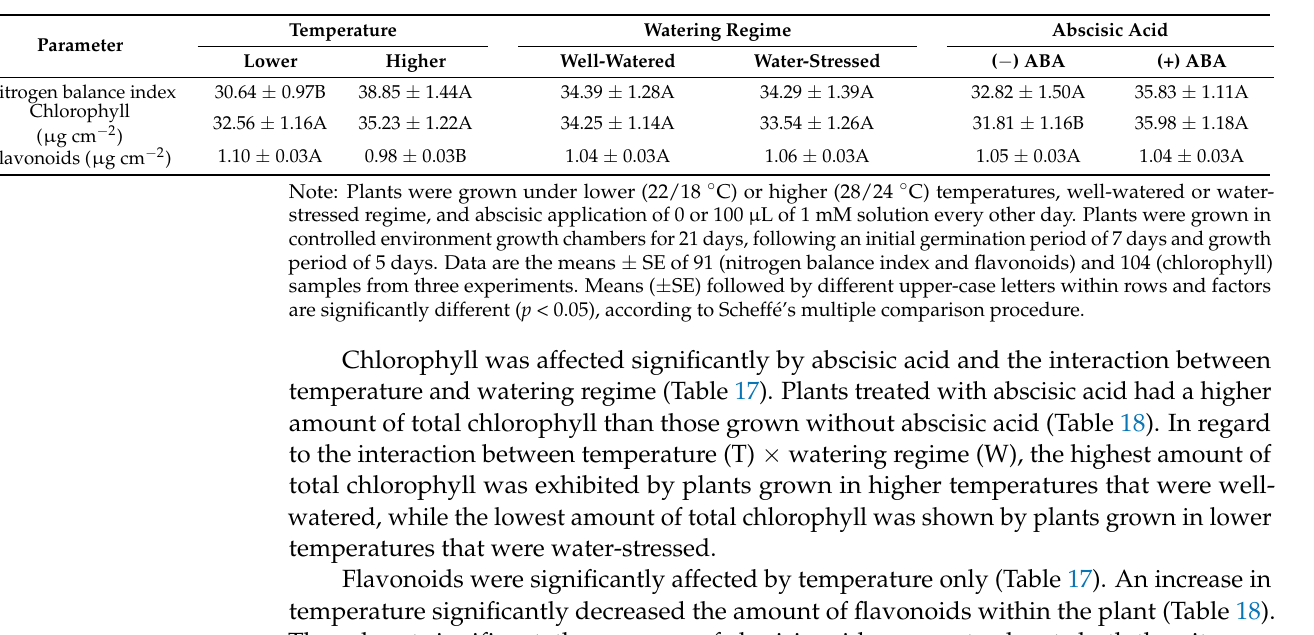
Table 18. Effects of temperature, watering regime and abscisic acid on nitrogen balance index, chlorophyll and flavonoids of tomato